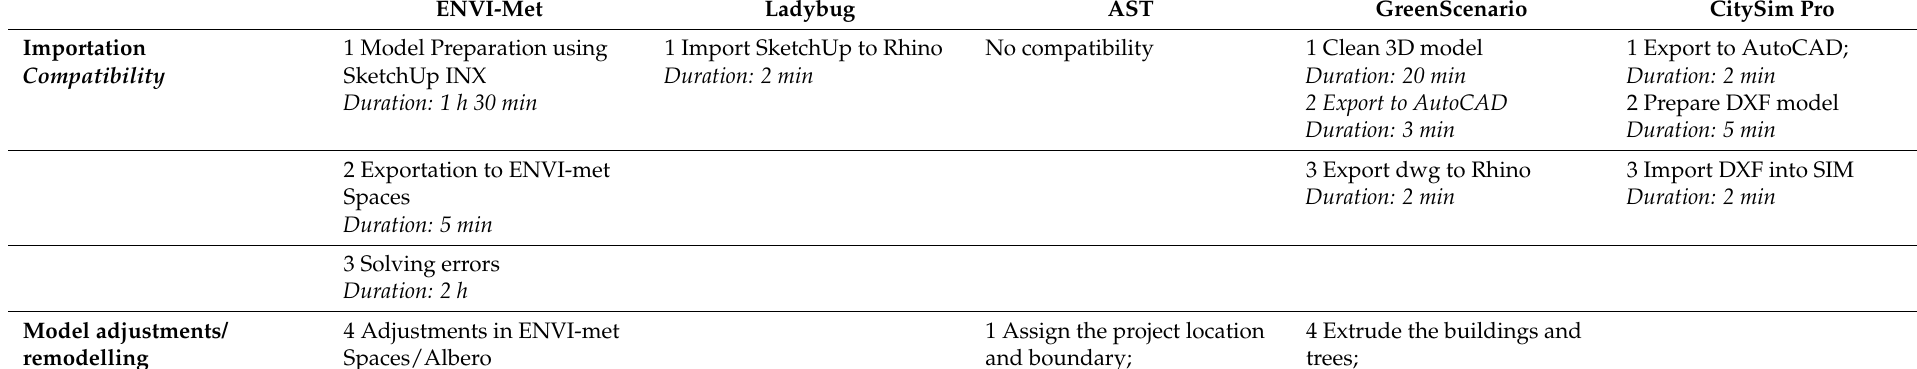
Table 3. The comparison of the functional appropriateness and performance efficiency of different software tools (source: authors). ENVI-Met Ladybug AST GreenScenario CitySim